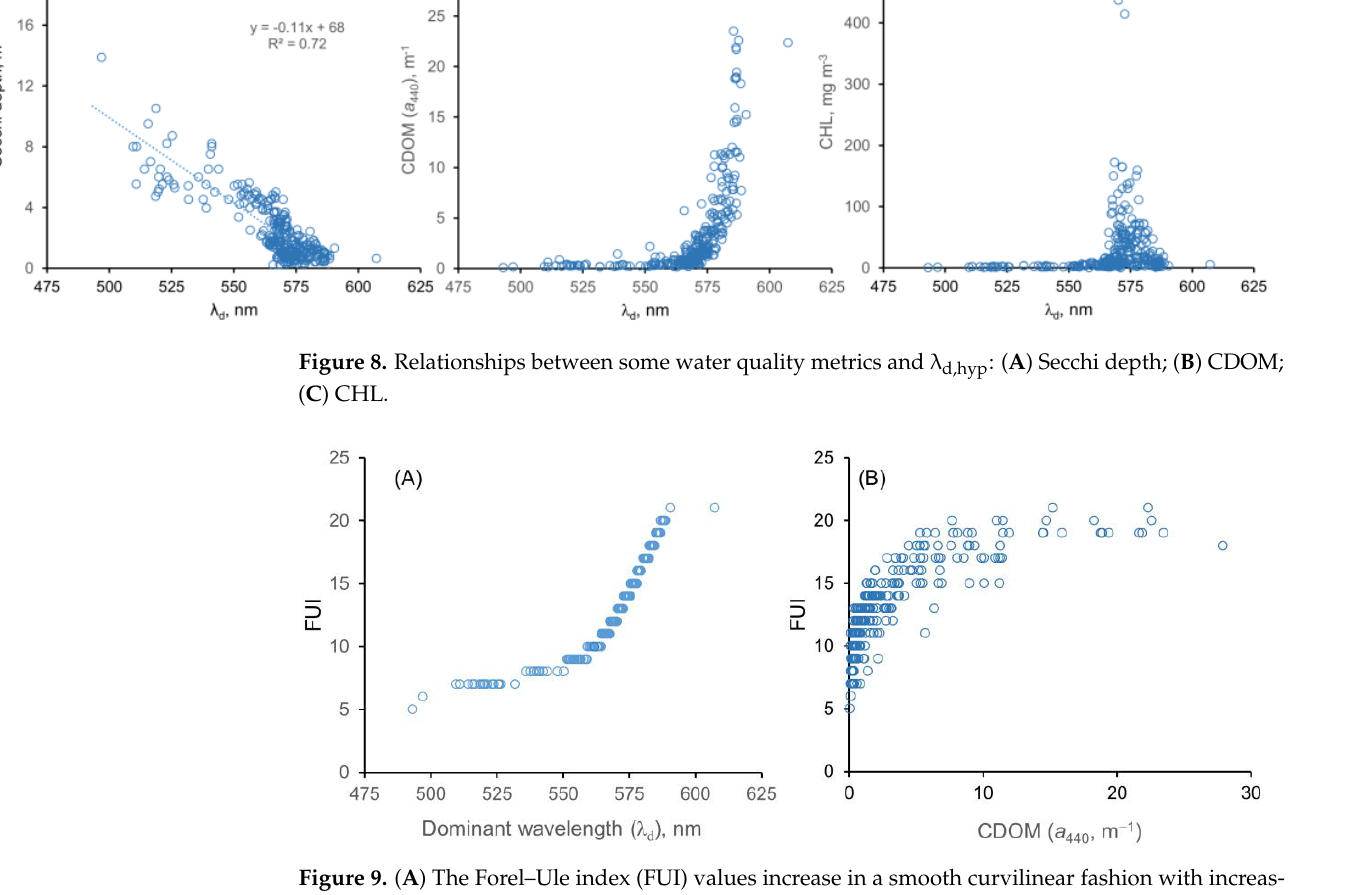
Figure 9. ( A ) The Forel – Ule index (FUI) values increase in a smooth curvilinear fashion